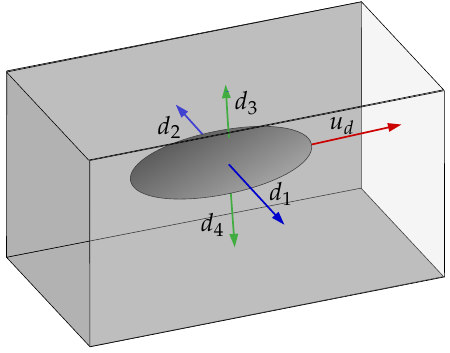
Figure 12. Distances measured by the VITA1